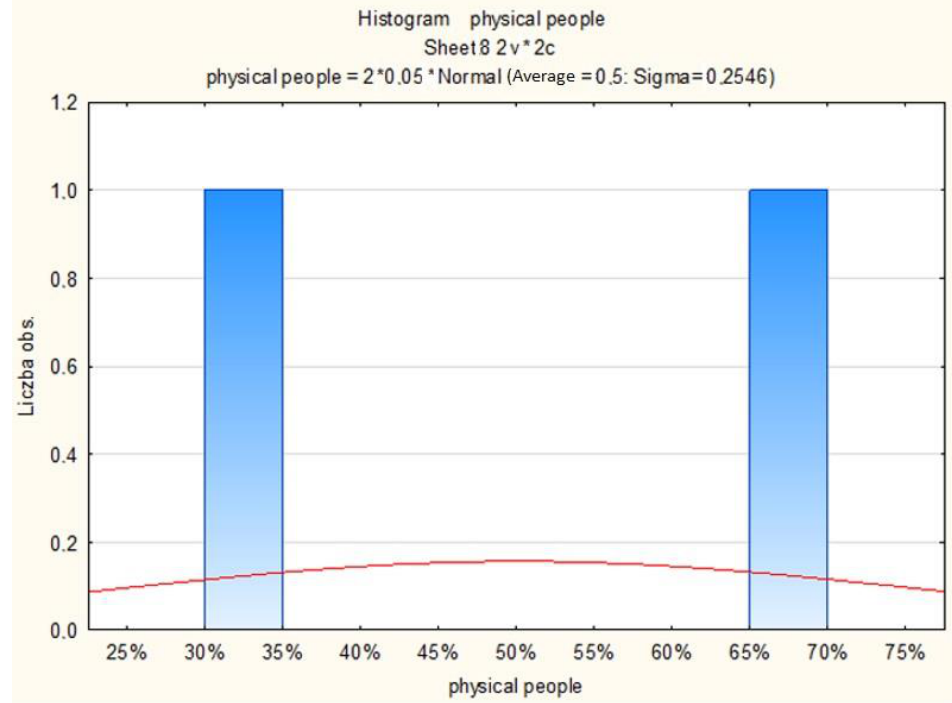
Figure 21. Structure of the participation of physical people in the survey. By making an analysis on the basis of a contour chart, an analysis of Poland ’ s chances of meeting the hydrogen assumptions was made (Figure 22). Poland ’ s chances of meeting the hydrogen targets are less perceived. Entrepreneurs have better chances than natural persons (who are not entrepreneurs). The chart below presents the ratio of the difference.